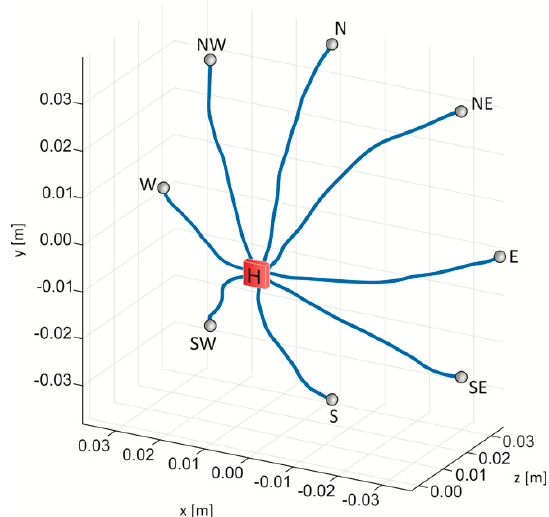
Figure 2. Representation of the 3D trajectories performed by the subjects from the home-base (H) to the 8 different targets (grey dots). The applied forces were always directed from the targets to the home base thereby changing the direction as soon as the subject moved the end effector in a different direction.